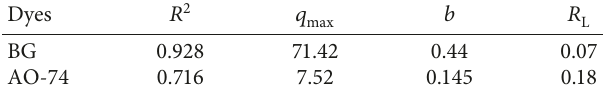
Table 6: Thermodynamic parameters.